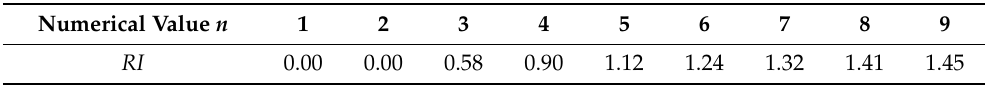
Table 10. Average random consensus indicator.